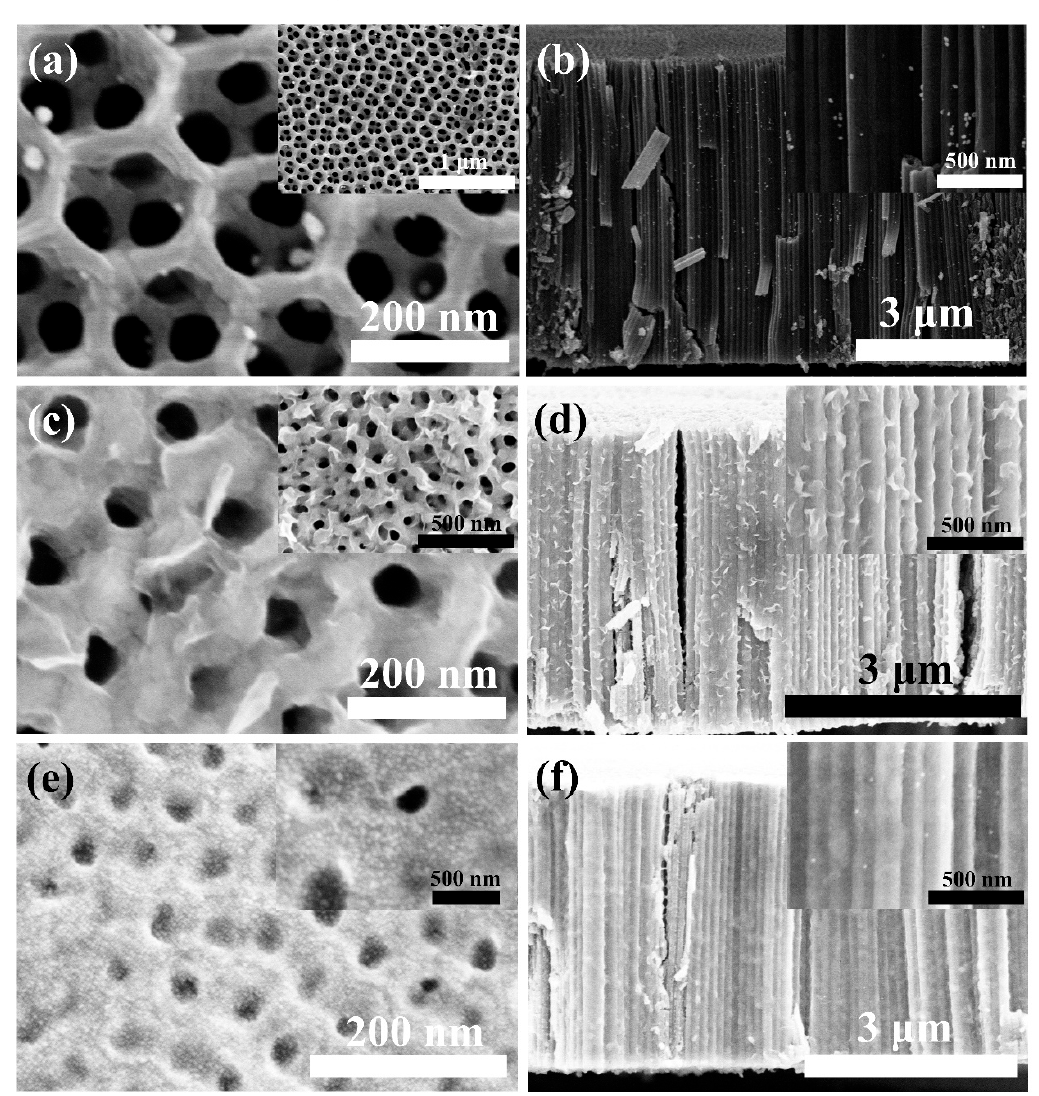
Figure 1. SEM images of ( a , b ) TiO 2 nanotube@Au nanoparticle (TiO 2 NT@Au NP) composite, ( c , d